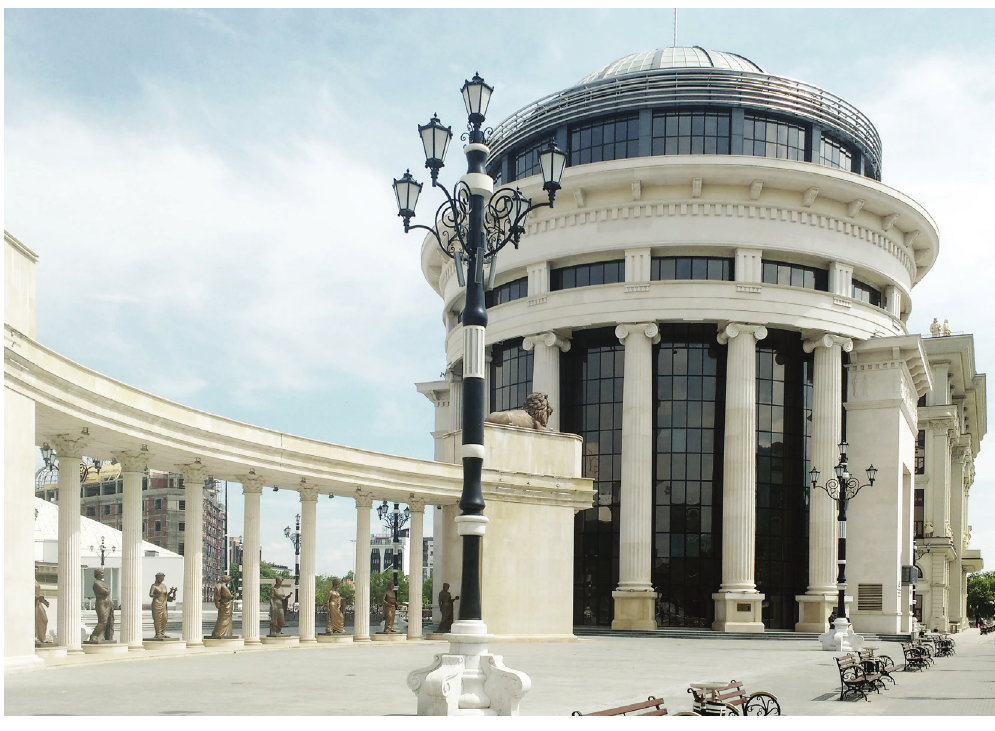
Figure 1 Giuseppe Resta,